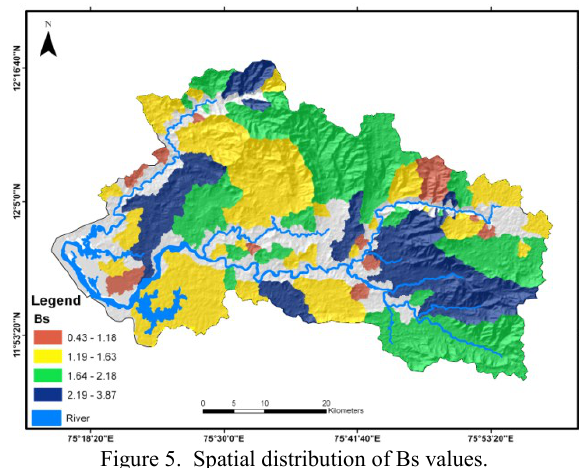
Figure 5. Spatial distribution of Bs values.